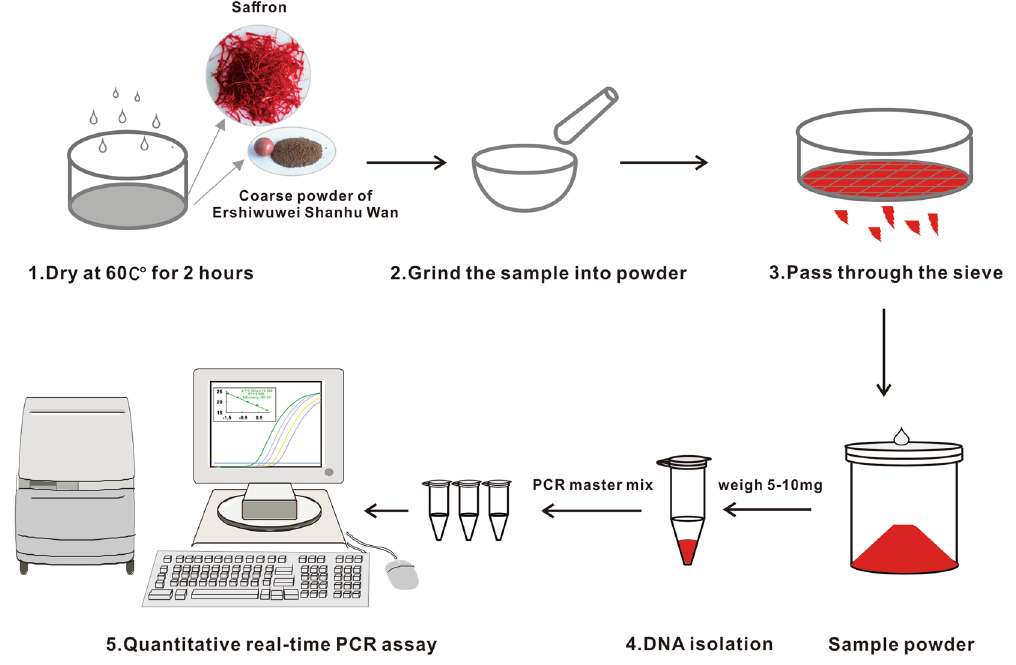
Figure 4. Workflow for quantitative detection of saffron in crude drugs or in Tibetan medicine “Ershiwuwei Shanhu Wan”. Step 1. Dry the saffron samples or coarse powder of “Ershiwuwei Shanhu Wan” at 60 °C for 2 hours to remove excessive water. Step 2. Grind the dried samples into powder. Step 3. Pass the powder through a 100 mesh sieve (saffron powder used for Ershiwuwei Shanhu Wan recovery test was passed through a 200 mesh sieve as it was used in the industrial production) to get homogenized samples. Step 4. Extract the DNA by direct plant DNA extraction solution. Step 5. Determine the saffron in crude drugs or Tibetan medicine